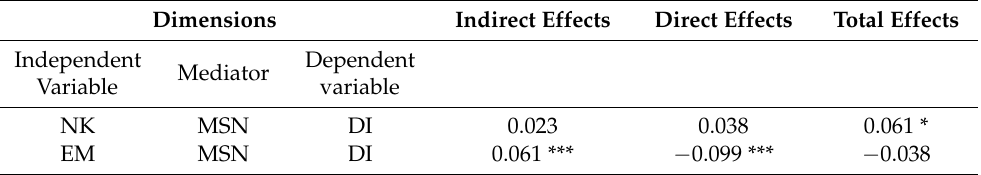
Table 4. Indirect, direct, and total standardized effects of determinants on intention to discard.